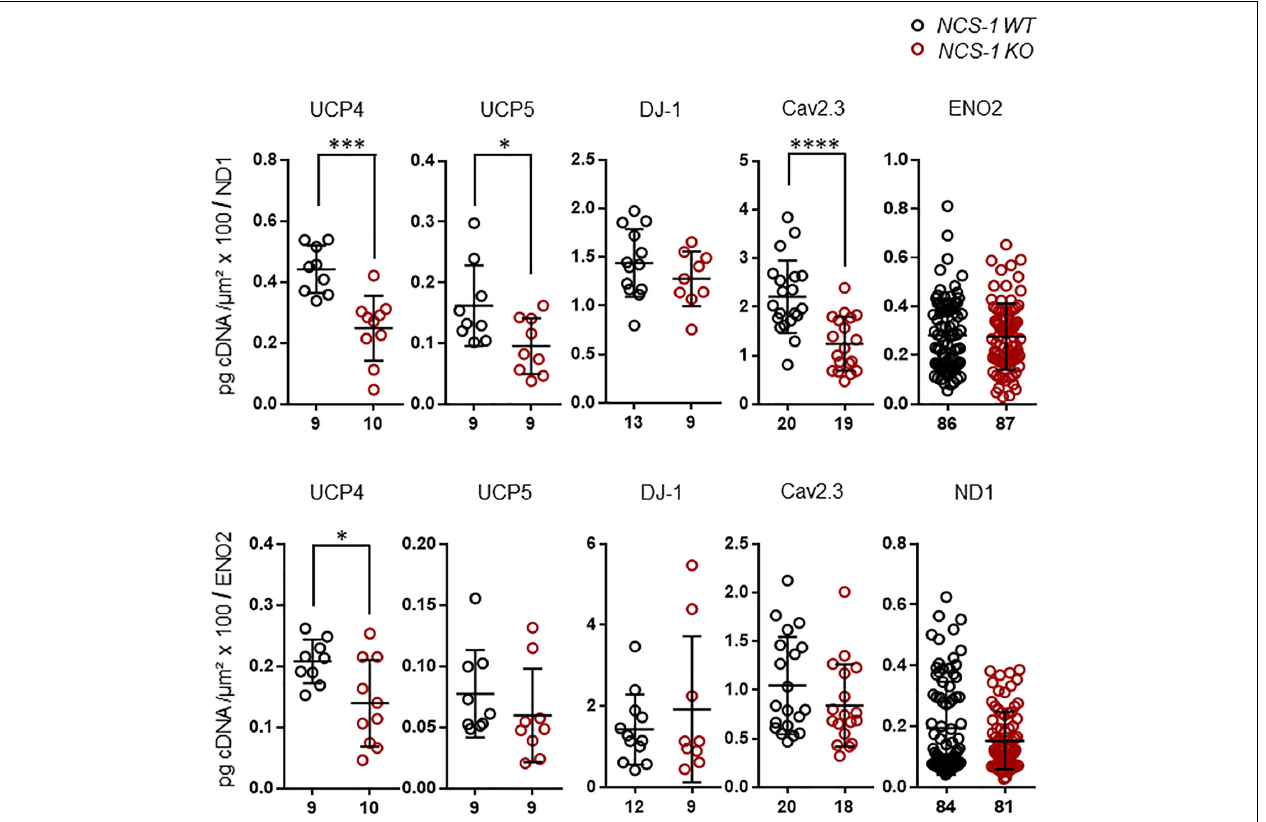
FIGURE 5 | RT-qPCR data for genes with altered expression in SN DA neurons from NCS-1 KO, in relation to ND1 and ENO2 mRNA expression for the same samples. Relative mRNA expression data for NCS-1 WT and KO, normalized to cell sizes, from Figures 2 , 3 , plotted in relation to that of ND1 and ENO2, as indicated. Data are given as scatter plots with mean ± SD. Significant differences are indicated according to Mann–Whitney U-tests and marked with asterisks ( ∗ p ≤ 0.05; ∗∗∗ p < 0.001, and ∗∗∗∗ p < 0.0001). Numbers of analyzed individual SN DA neuron-derived cDNA samples (n) are given on the x-axis. All data and statistics detailed in Supplementary Table S5